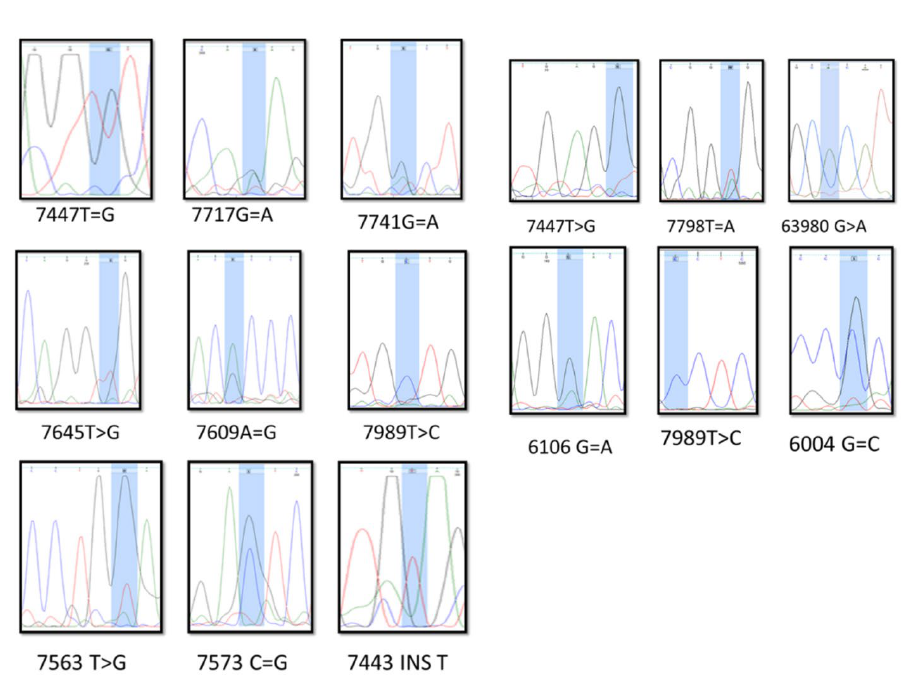
Fig.2. The result of the sequenced PCR